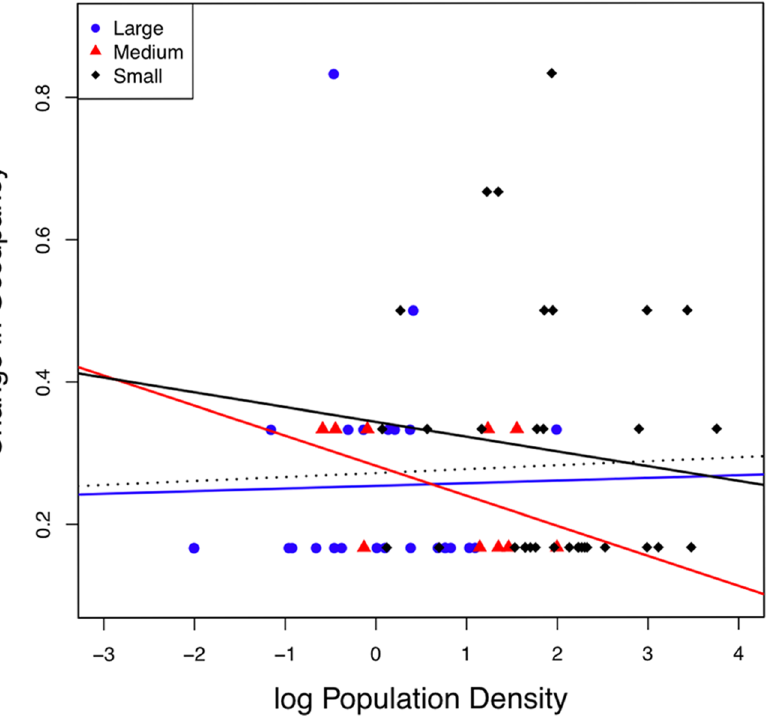
Figure 6. Occupancy vs. population density of pecies. Tests of the relationship of population density to increased site occupancy between the historical and modern time intervals for small, medium, and large bodied mammals. Regressions were calculated for all species (black; y=.271 + .005X, R 2 =0.002, F=0.125, p=.724) and small (yellow; y=.343–.021X, R 2 =0.011, F=0.359, p=.553), medium (green; y=.282–.042X, R 2 =0.211, F=2.144, p=.181) and large bodied (blue; y=.253 + .004X, R 2 =4.93E–4, F=0.011, p=.916) species separately. Data for all occupancy changes including decreases available upon request.